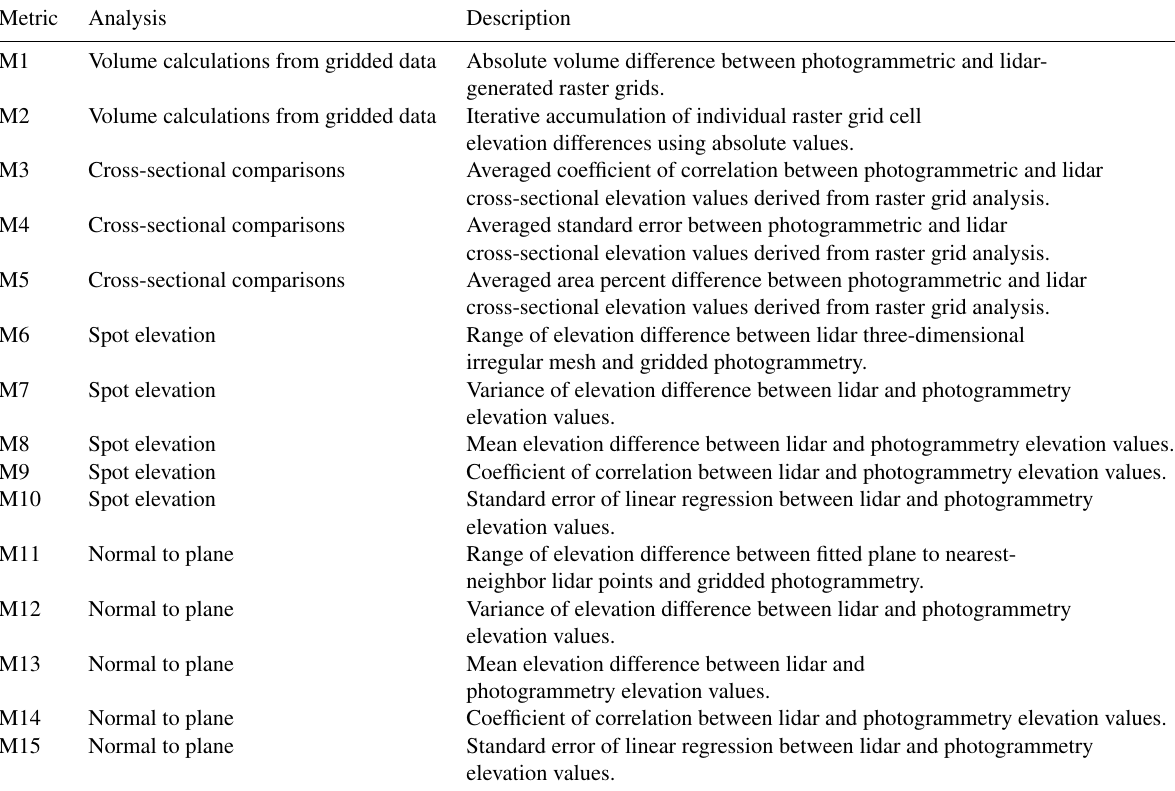
Table 2. Metrics used in the ranking analysis of the photogrammetric measurements. Metric Analysis Description M1 Volume calculations from gridded data Absolute volume difference between photogrammetric and lidar- generated raster grids. M2 Volume calculations from gridded data Iterative accumulation of individual raster grid cell elevation differences using absolute values. M3 Cross-sectional comparisons Averaged coefficient of correlation between photogrammetric and lidar cross-sectional elevation values derived from raster grid analysis. M4 Cross-sectional comparisons Averaged standard error between photogrammetric and lidar cross-sectional elevation values derived from raster grid analysis. M5 Cross-sectional comparisons Averaged area percent difference between photogrammetric and lidar cross-sectional elevation values derived from raster grid analysis. M6 Spot elevation Range of elevation difference between lidar three-dimensional irregular mesh and gridded photogrammetry. Spot elevation Variance of elevation difference between lidar and photogrammetry elevation values. Mean elevation difference between lidar and photogrammetry elevation values. Coefficient of correlation between lidar and photogrammetry elevation values. Standard error of linear regression between lidar and photogrammetry elevation values. Normal to plane Range of elevation difference between fitted plane to nearest- neighbor lidar points and gridded photogrammetry. Normal to plane Variance of elevation difference between lidar and photogrammetry elevation values. Normal to plane Mean elevation difference between lidar and photogrammetry elevation values. Normal to plane Coefficient of correlation between lidar and photogrammetry elevation values. Normal to plane Standard error of linear regression between lidar and photogrammetry elevation